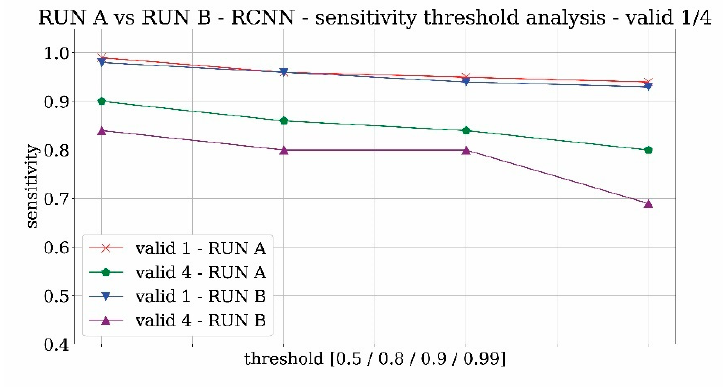
Figure 12. Sensitivity threshold analysis for RUN A and RUN B with valid 1 and 4.